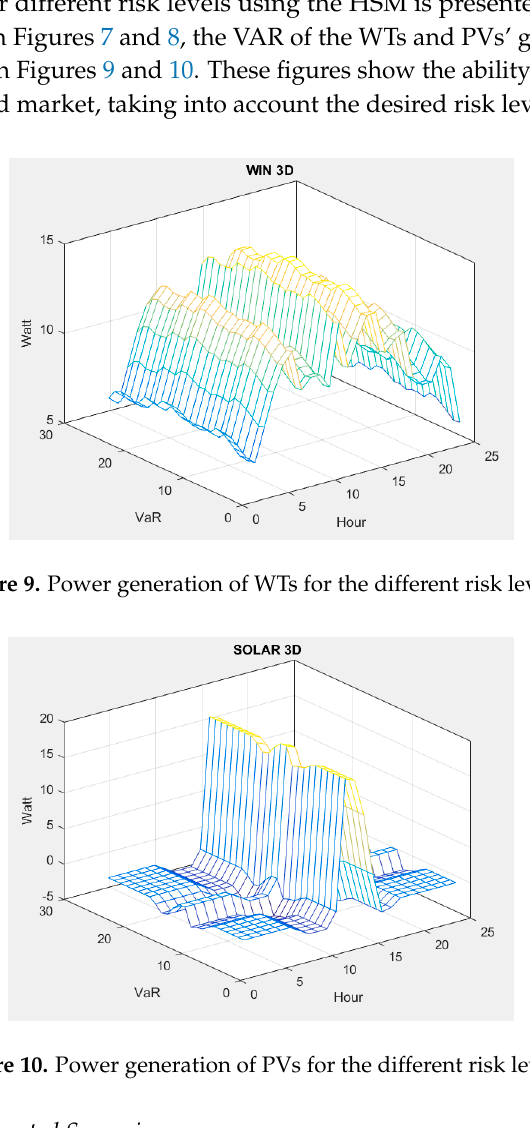
Table 2. VAR at the various confidence levels.